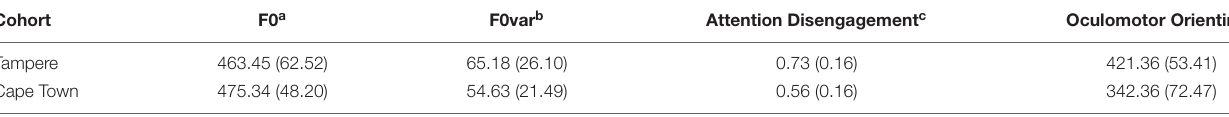
TABLE 1 | Descriptive data of the main study variables for the Tampere and Cape Town cohorts. Cohort F0 a